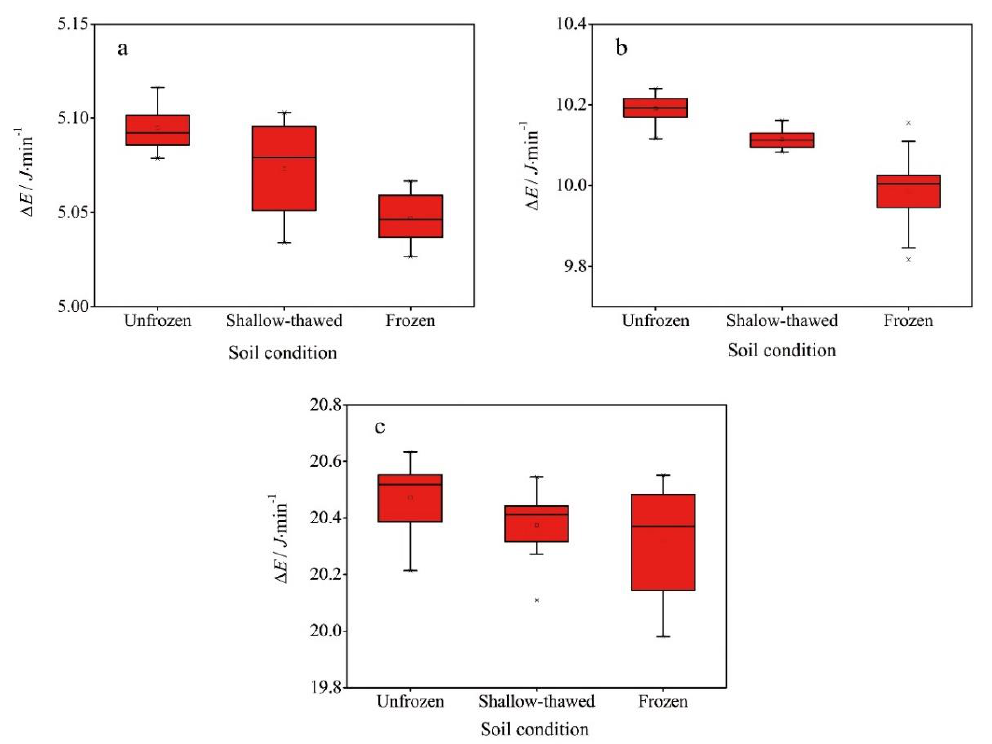
Figure 5. The box plot of the energy consumption at different soil conditions at 1 L/min ( a ), 2 L/min ( b ), and 4 L/min ( c ).